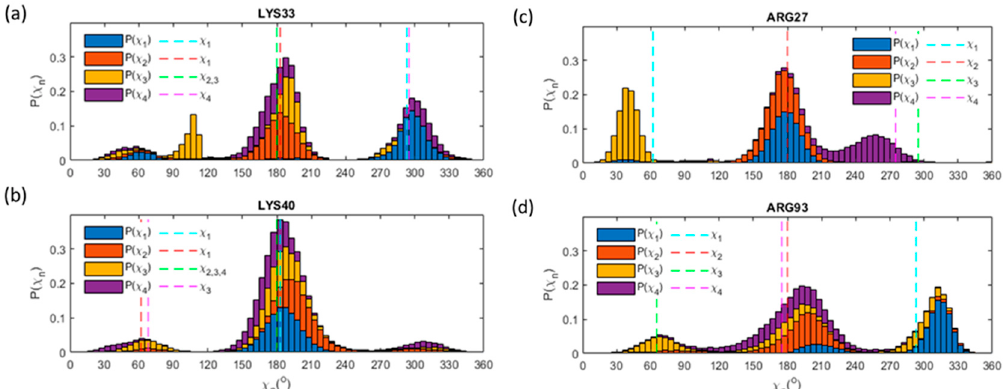
Figure 9. Stacked bar graph of side-chain χ 1 , χ 2 , χ 3 , χ 4 torsions probability distributions for Lys33 ( a ), Lys40 ( b ), Arg27 ( c ) and Arg93 ( d ). Each probability distribution of χ i was normalized so that P ( χ i ) d x i = 1 . The probability values within 5 ◦ × 5 ◦ bins for separate torsion angles were marked as blue, orange, yellow, and purple, respectively. Appropriate values of χ 1 , χ 2 , χ 3 angles from the experimental Hyp-1 model were presented sequentially as light blue, orange, and light green dashed lines. If one χ i value was common for multiple torsion angles in the side chain, we marked them as a single line with a proper index to prevent line overlap and confusion during figure inter- pretation.